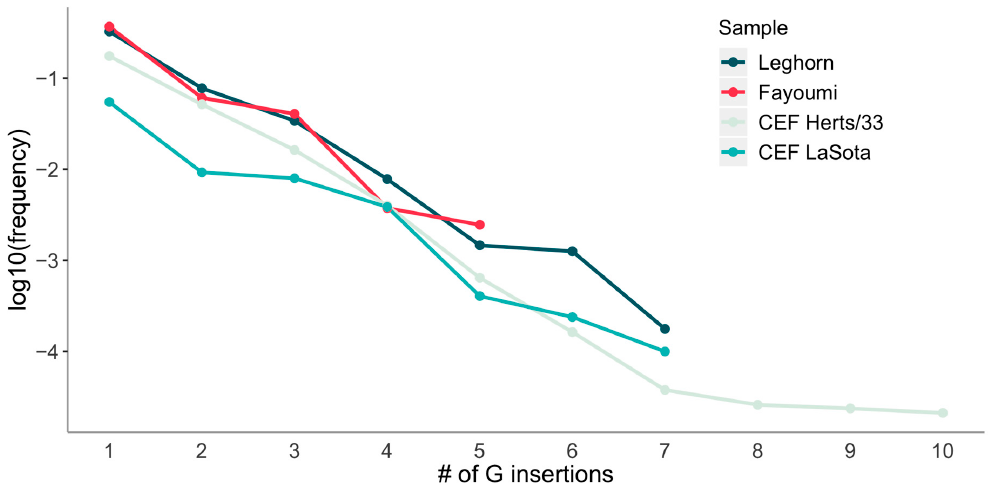
Figure 3. Log-plot of mRNA fraction with a given length of G insertions, averaged among all samples from the same experiment.